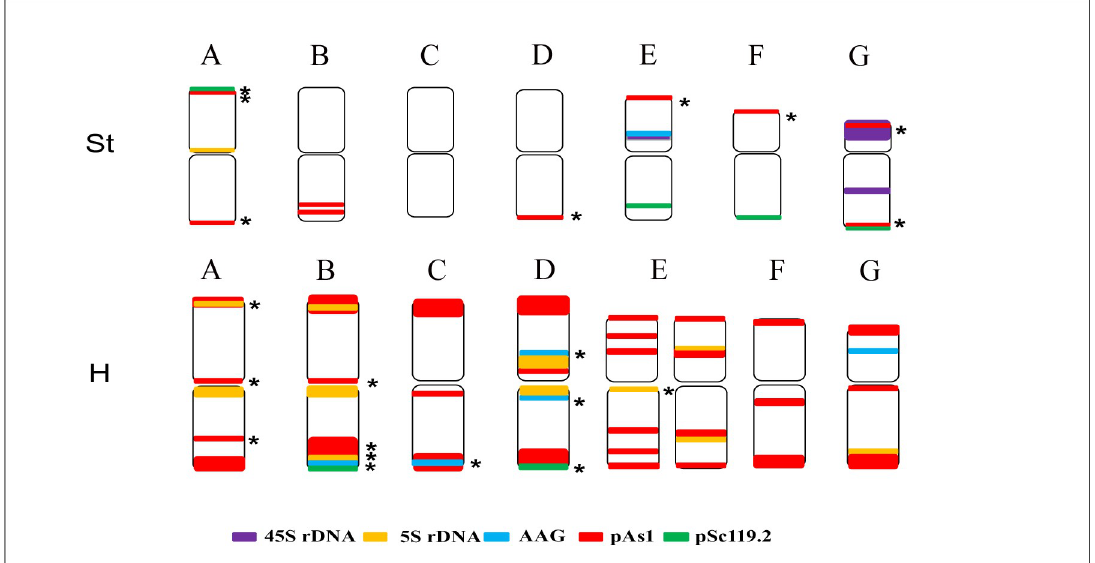
Fig 4. Ideogram of FISH-banded chromosomes of Elymus sibiricus . The black star next to the FISH signal indicates the polymorphisms.